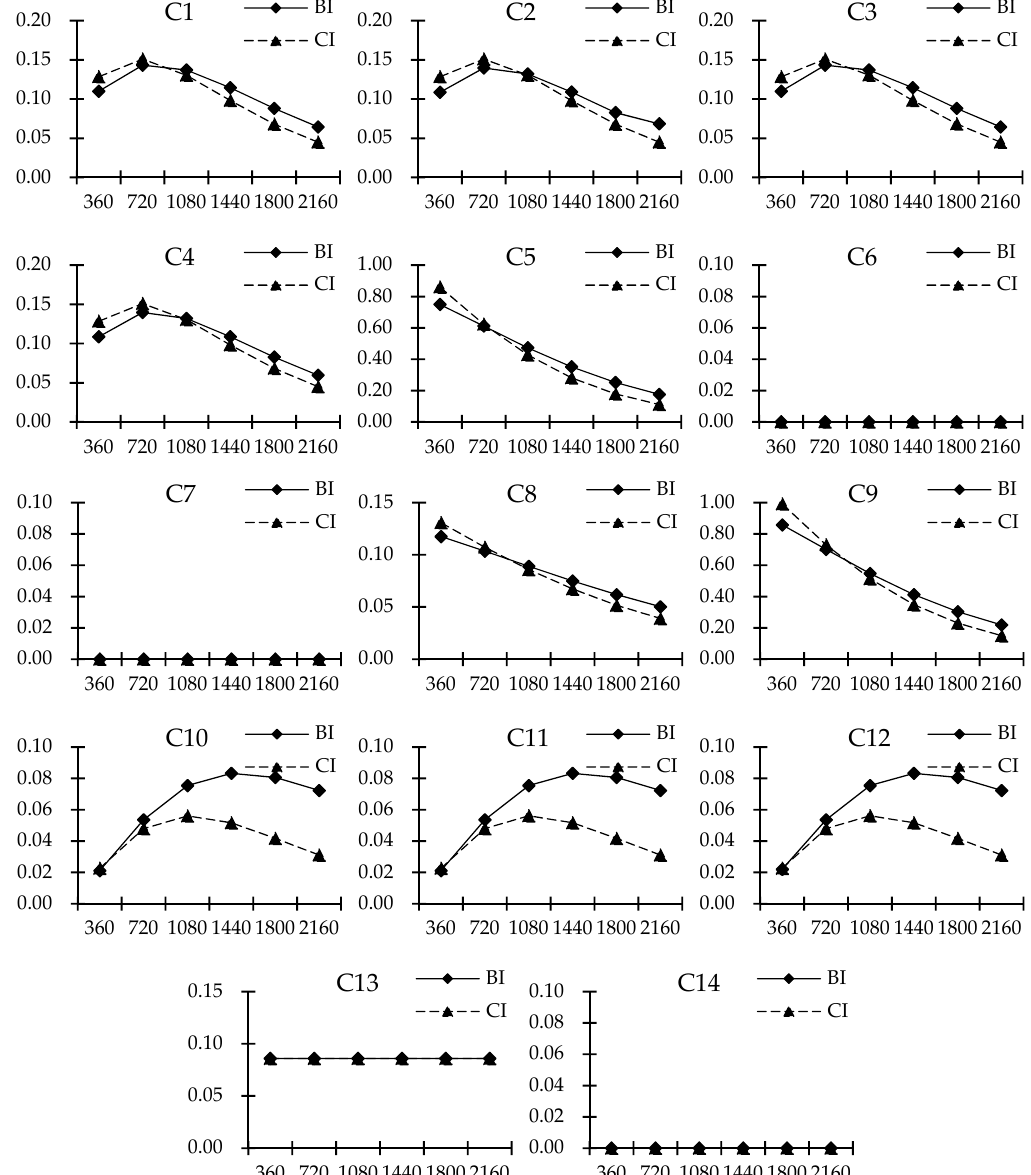
ff erent operational time when P N equals to P out